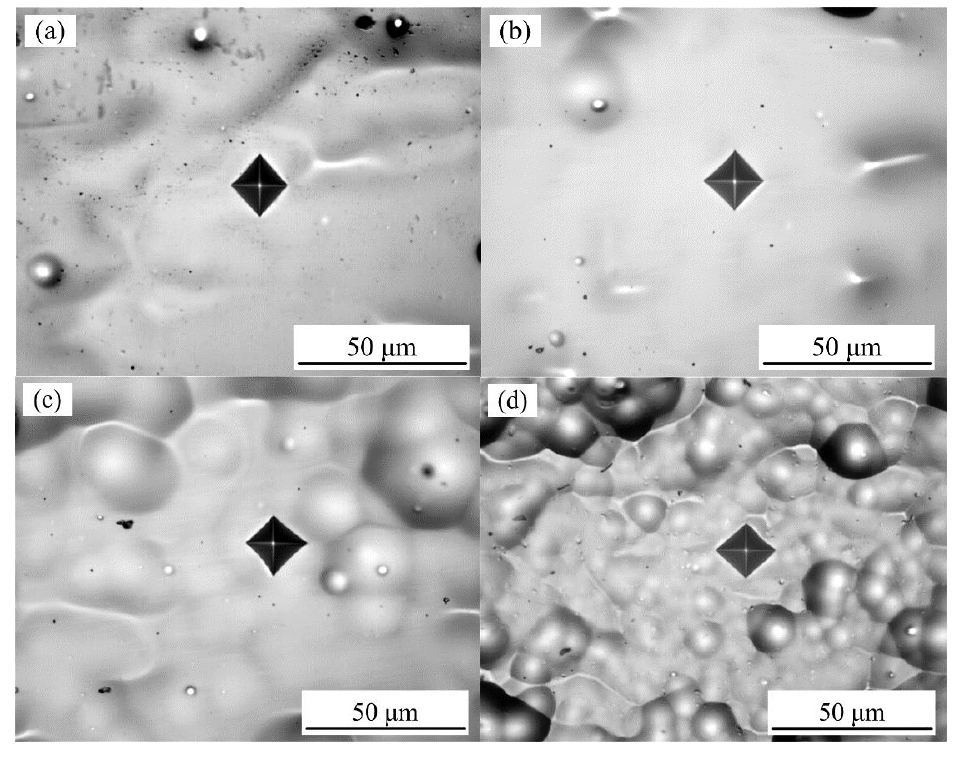
Figure 7. Optical microscopy images of the Vickers indent for ( a ) 10 V, 60 °C; ( b ) 12 V, 60 °C; ( c ) 20 V, 60 °C; and ( d ) 75 °C, 12 V.